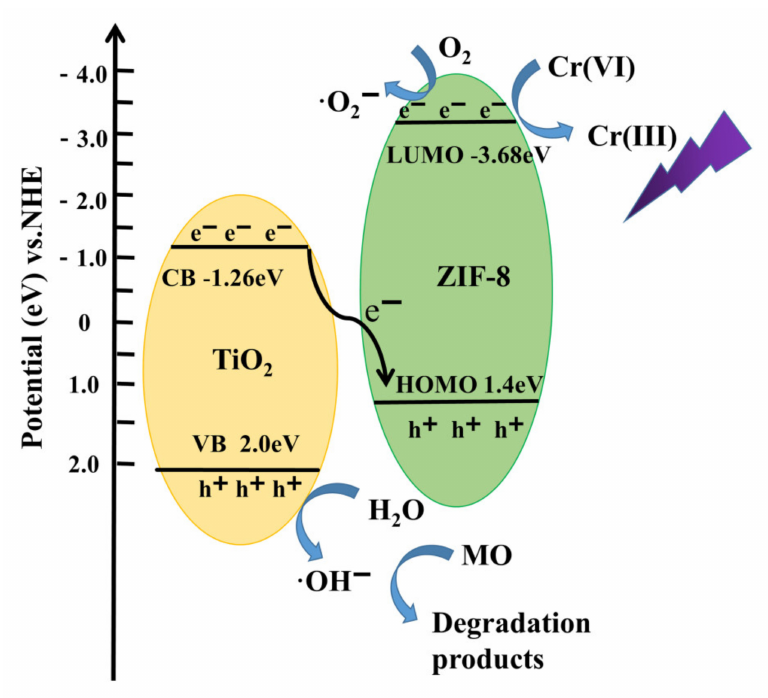
Figure 9. The photo-catalysis mechanism of Cr(VI) and MO and energy-band gap of Z100T200.